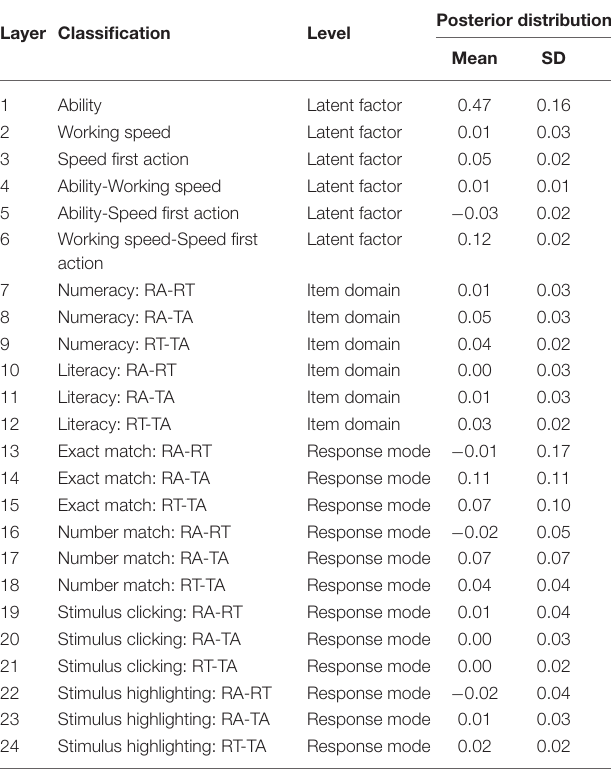
TABLE 9 | Posterior means and standard deviations of the N t = 24 covariance parameters in the additive covariance structure. Layer